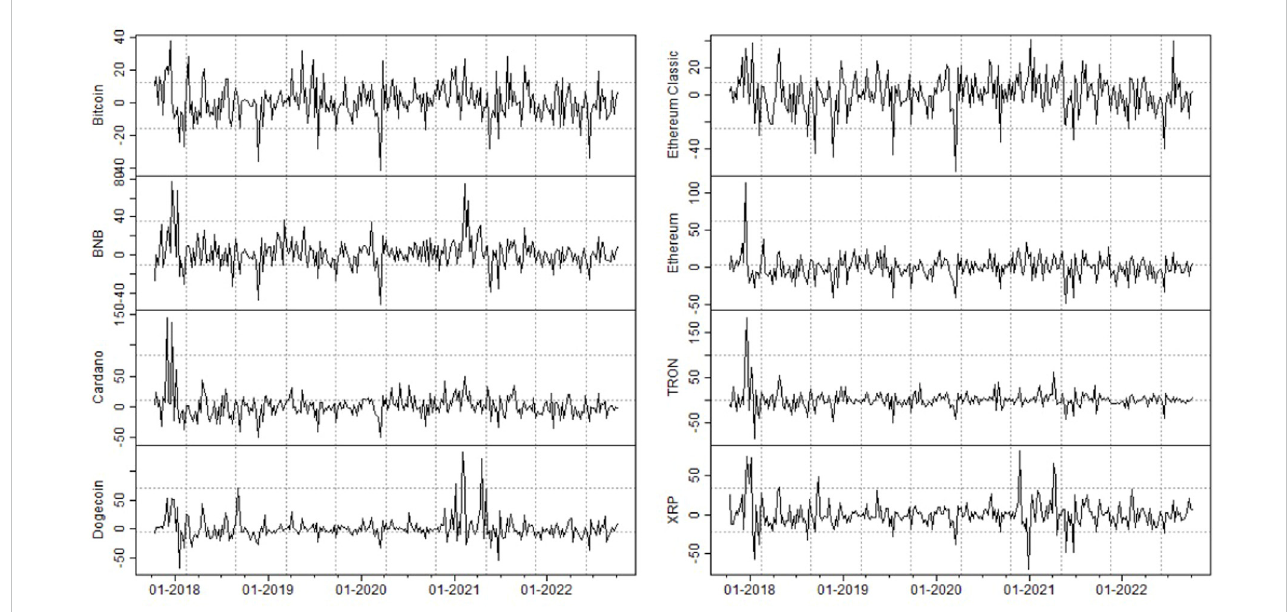
FIGURE 1 Change rates of cryptocurrencies (%). The plots are labeled using the name of the cryptocurrencies.